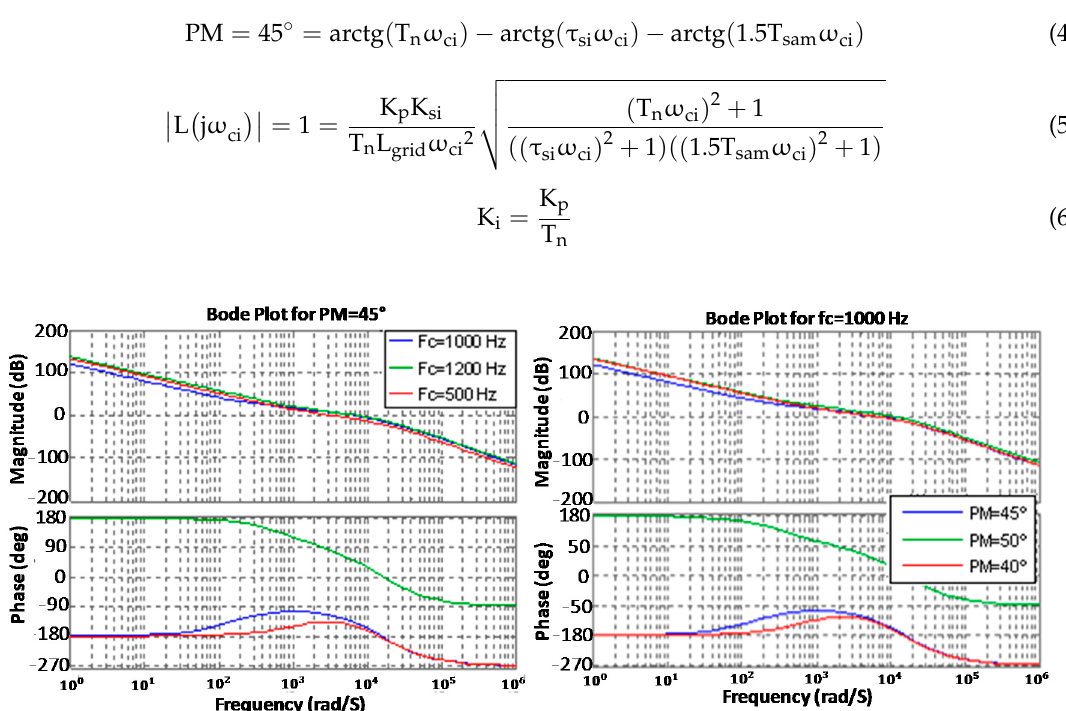
Figure 11. Bode Plots of the Grid Current Loop for various fc and PM.